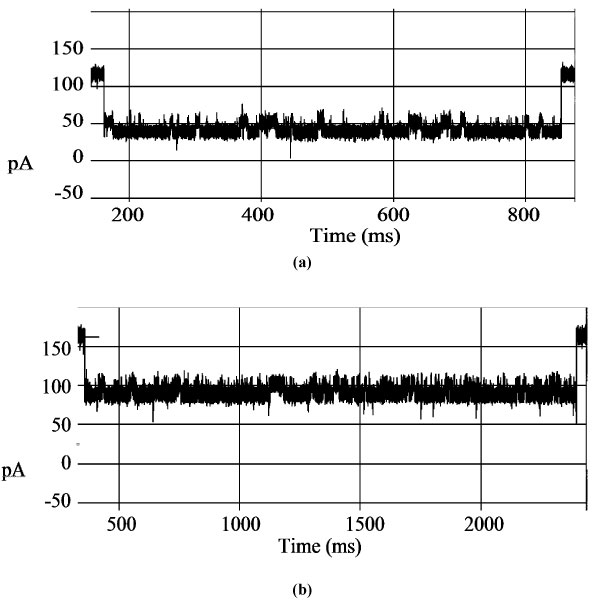
Panel (a) shows the sought-after toggler-type signal. Panel (b) Shows the modification to the toggler-type signal shortly after addition of 5-base ssDNA. Note: the blockade timescales are not the same, 0.7 seconds on (a) and 2.0 seconds for (b). The observed change is hypothesized to represent annealing by the complimentary 5-base ssDNA component, and thus detection of the 5-base ssDNA molecule. The "lengthy" toggler signal (a) was of briefer duration than desirable, by at least a magnitude, but modifications along the lines of the Y-aptamer geometries have recently yielded excellent results for characterizing binding properties (a work-in progress).